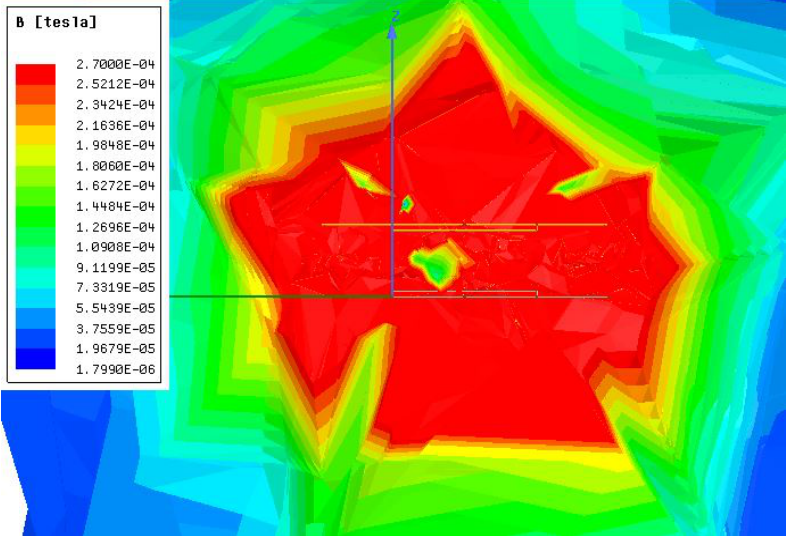
Figure 11. Magnetic field intensity plot of the inductive link with no ferrite and shielding